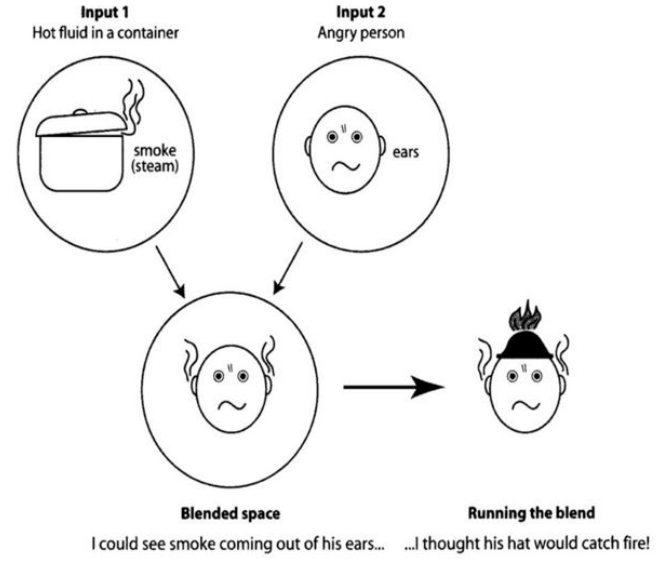
Figure 4: Smoke from Ears & Hat on